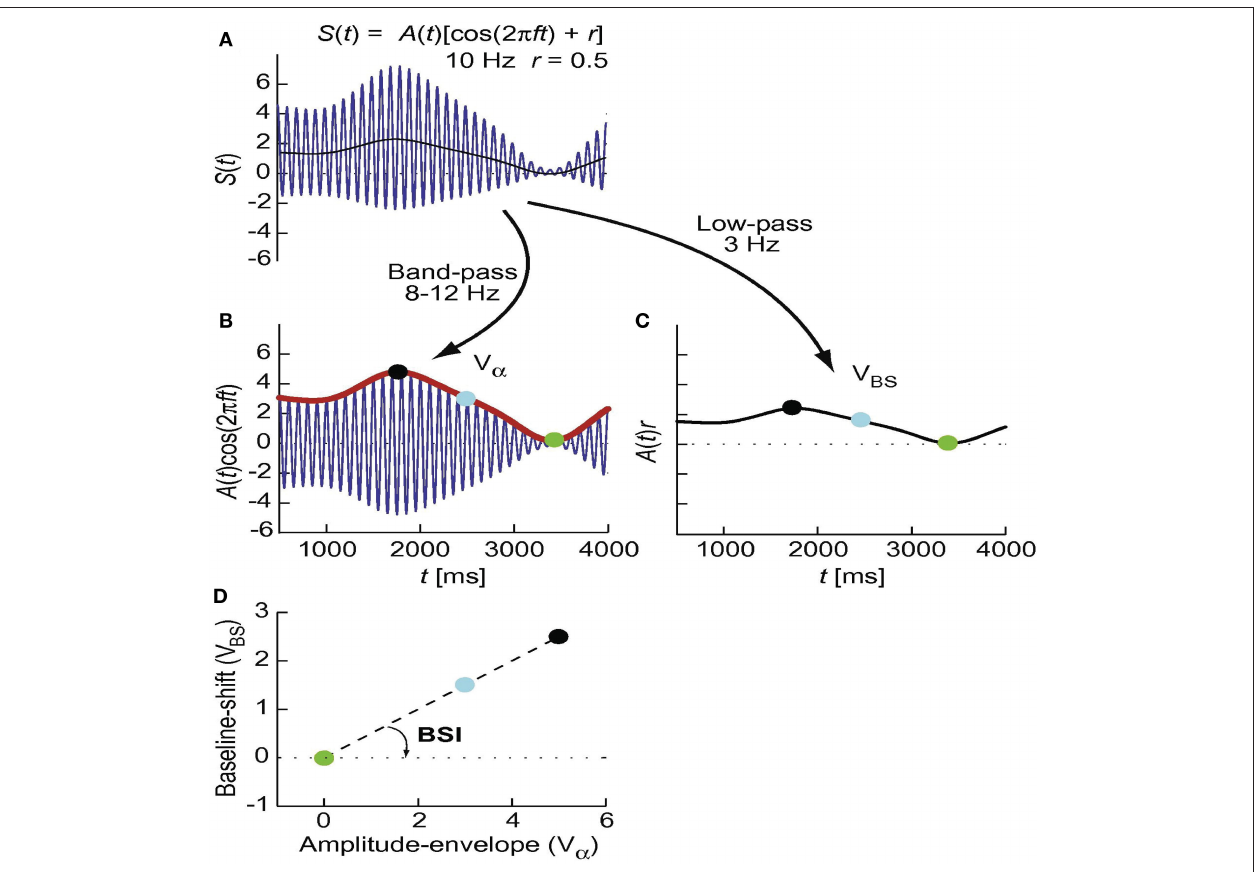
Figure 7 | Schematic presentation of the derivation of the baseline shift e.g., at 3 Hz (C) . The amplitude-envelope values are sorted into bins (e.g., 20 index (BSi). First, the signal in (A) is filtered in two ways to separate the bins) and values from the baseline shift signal are sorted into the amplitude envelope of the oscillations and the baseline shift A(t)r [thin black corresponding bins (note the temporal correspondence of dots with the same line in (A) ]. The amplitude envelope (V ) is obtained using bandpass filters color). (D) Within-bin averaged values for the amplitude envelope and baseline α (e.g., 8–12 Hz) and the Hilbert transform [ (B) , red thick line]. The baseline shifts are plotted against each other and the slope of the regression line is shifts (V ) are part of the signal at considerably lower frequencies than the calculated. This slope is the baseline shift index or BSI. Adapted from Nikulin BS oscillatory “carrier” signal and, therefore, are obtained by lowpass filtering, et al.